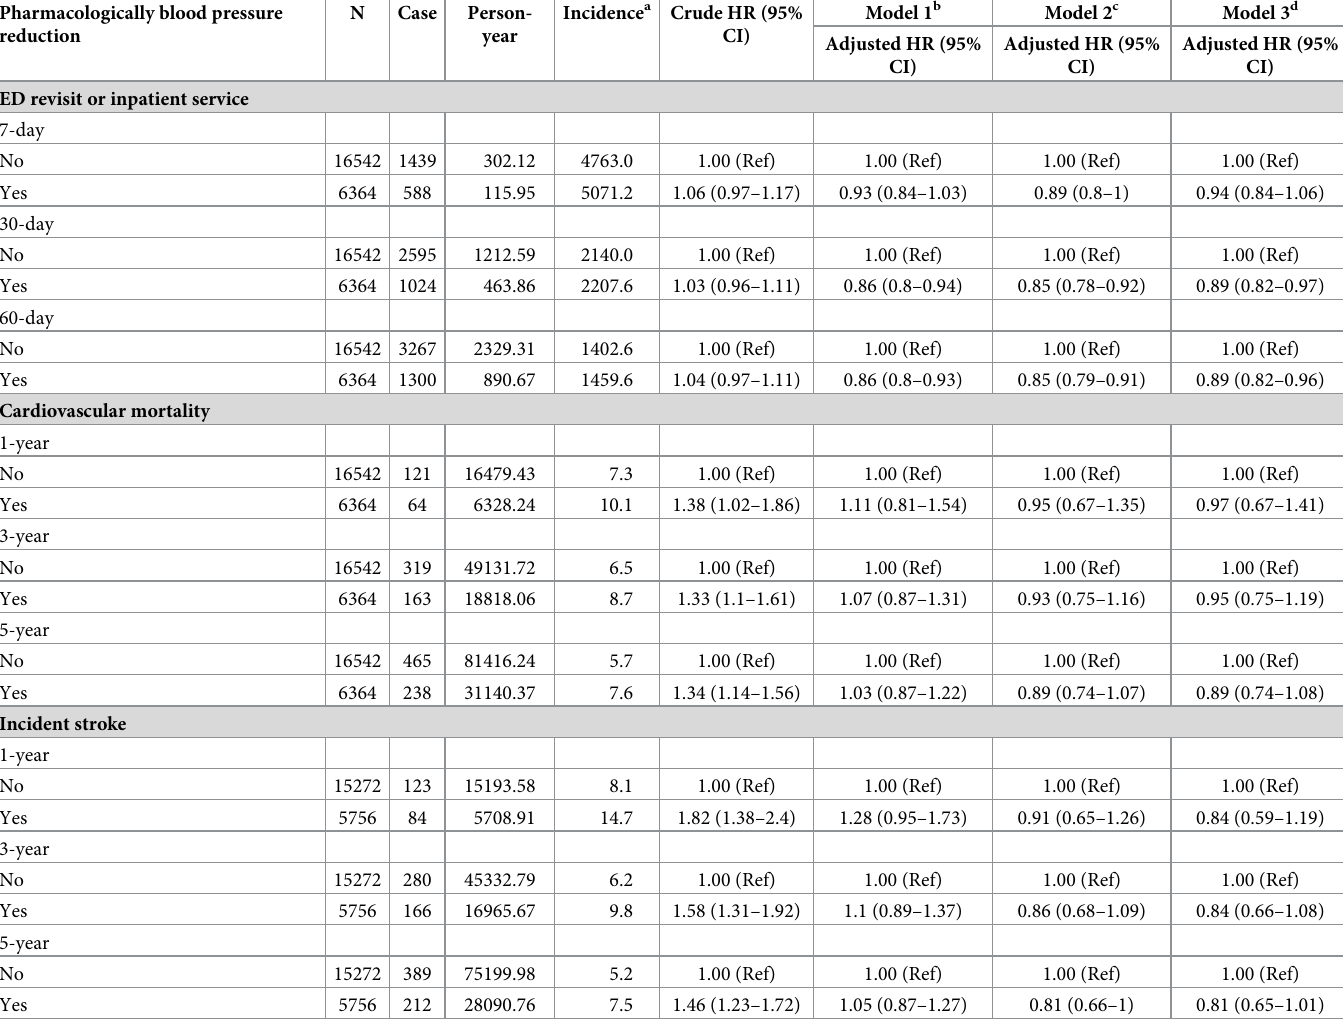
Table 2. Hazard ratios (HRs) with 95% confidence interval for ED revisit or inpatient admission, incident stroke, and cardiovascular mortality according to the exposure of pharmacological BP control in the ED setting. Pharmacologically blood pressure